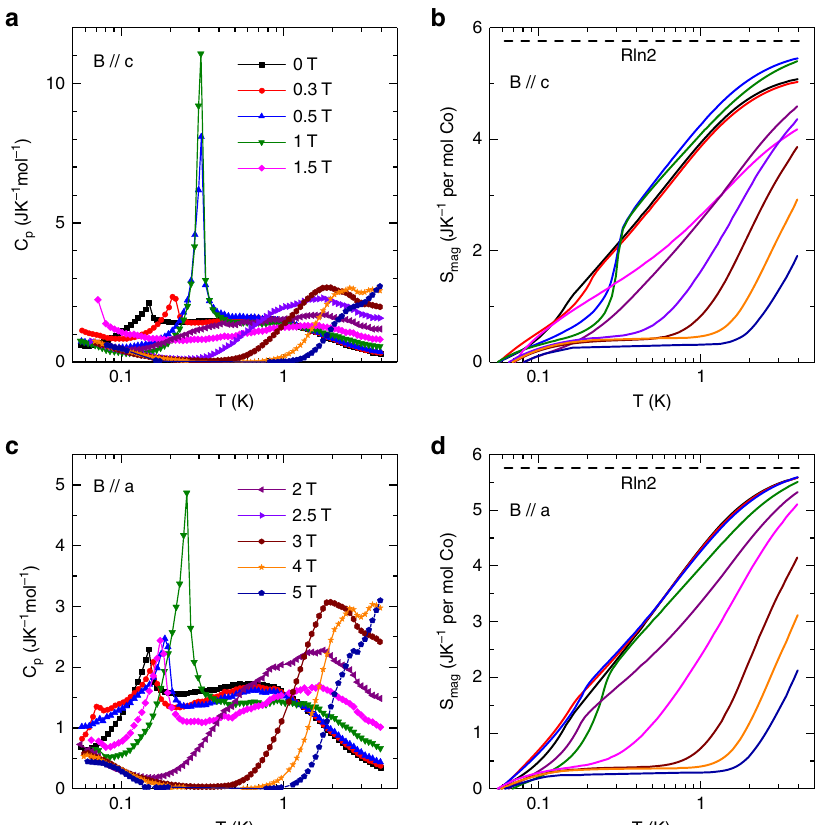
Fig. 3 Ultralow-temperature speci fi c heat of Na 2 BaCo(PO 4 ) 2 . a , c The zero- fi eld data and those in different magnetic fi elds along the c axis or the a axis. The temperature range is 50 mK to 4 K. b , d The magnetic entropy for B // c and B // a , obtained by integrating the magnetic speci fi c